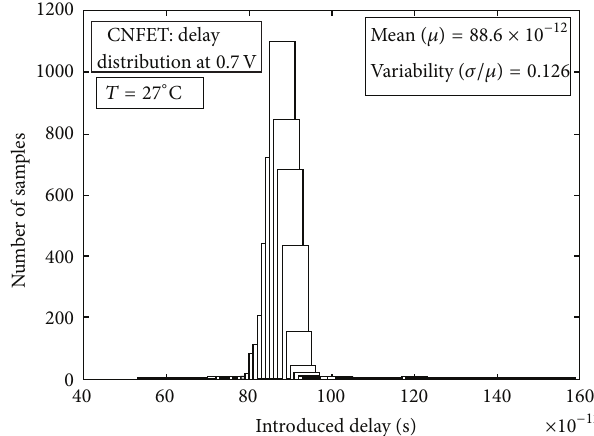
Figure 15: Introduced delay distribution plot of the CNFET based proposed buffer delay circuit.